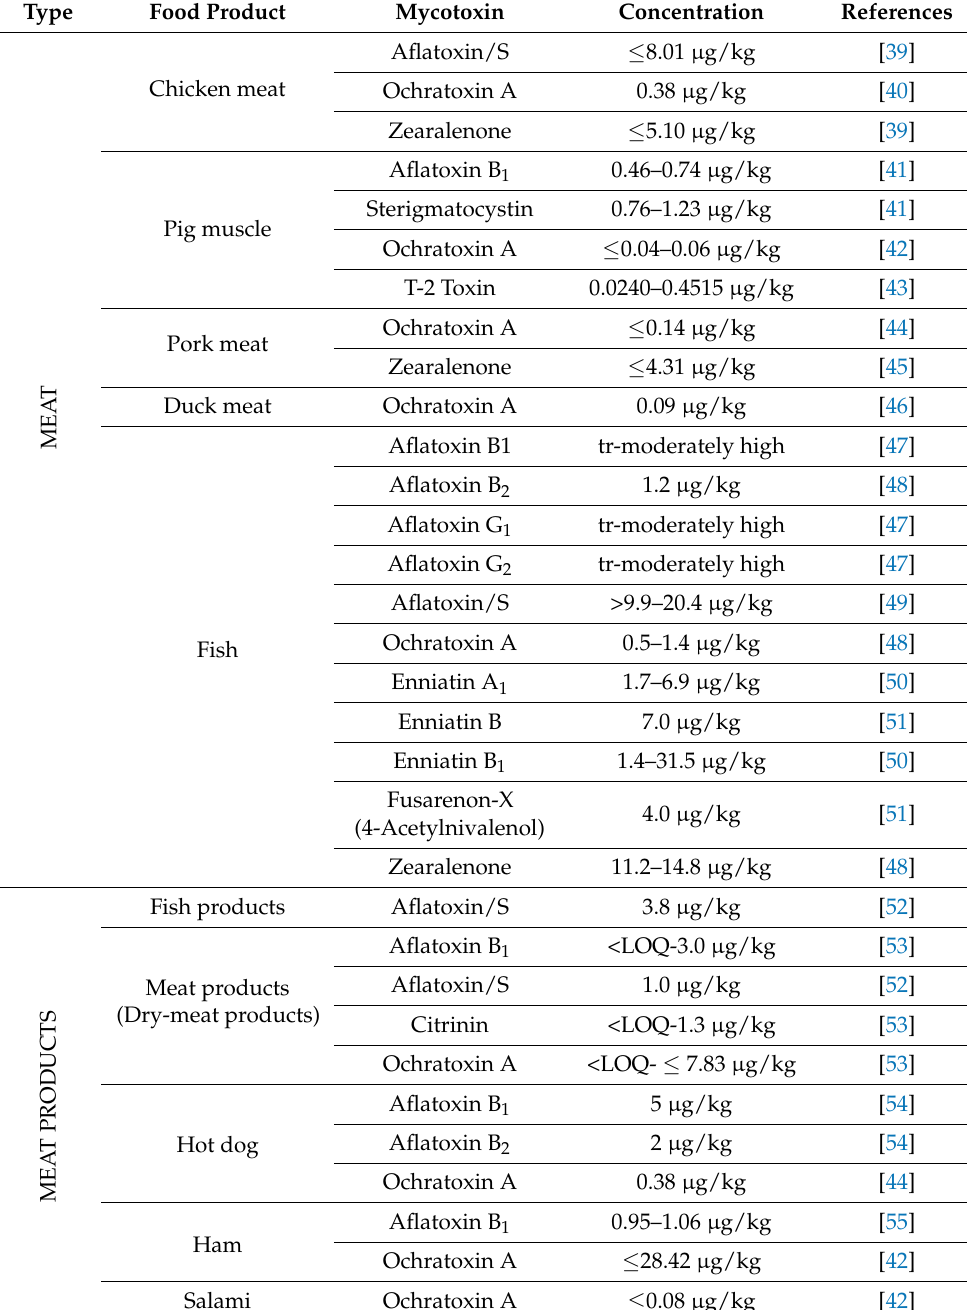
Table 2. Mycotoxins identified in meat and meat